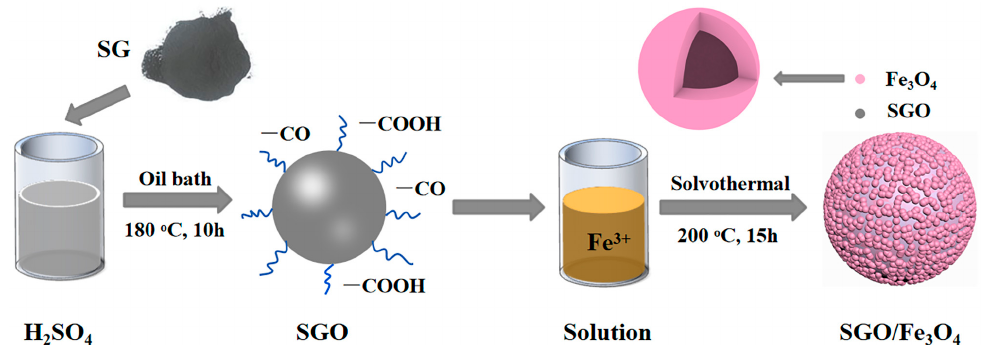
Figure 1. Preparation process of SGO/Fe 3 O 4 composites.